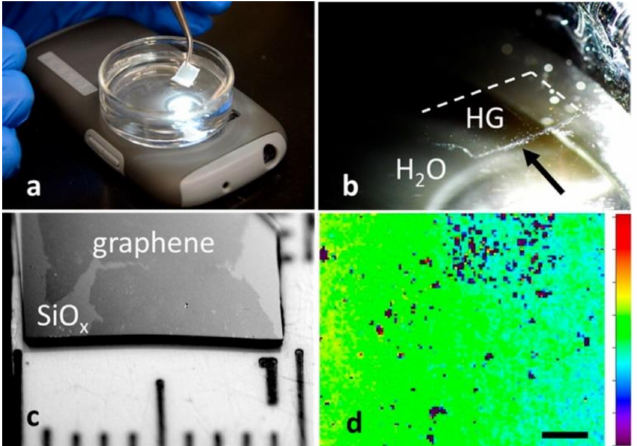
Figure 6. Hydrogen-facilitated graphene transfer. ( a ) Experimental setup of delamination of hydro- genated graphene directly into water. ( b ) Image of hydrogenated graphene floating on water. ( c ) Thermally restored graphene on a target SiO x substrate. ( d ) Raman map of D peak of hydrogenated graphene showing retention of chemical functionality. Reprinted with permission from Ref. [63]. Copyright 2016 American Chemical